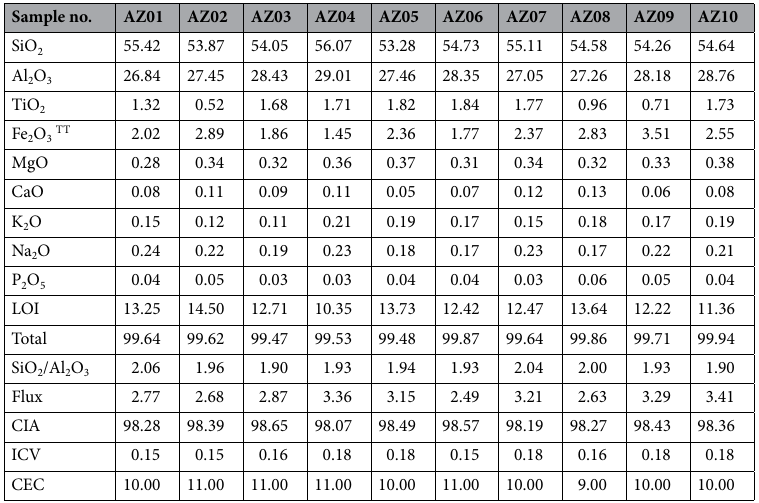
Table 3. The chemical composition of major oxides (wt%), loss of ignition, and alteration indices of the studied bulk samples. TT total iron as Fe 2 O 3 , LOI loss on ignition, CIA chemical index of alteration, ICV index of composition variability, CEC cation exchange